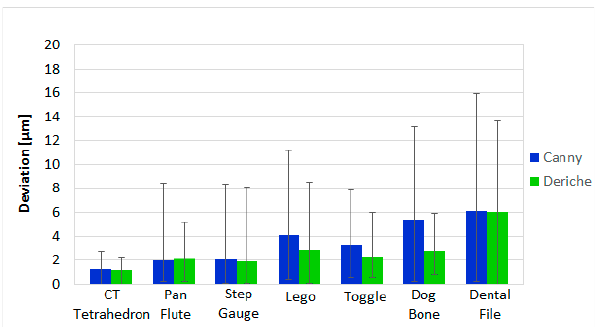
Figure 8. Average deviation for the Canny-based method (blue bars) and Deriche-based method (green bars) and maximum and minimum deviation (error bars) of all the part dimensions from their calibrated absolute values of single material parts.